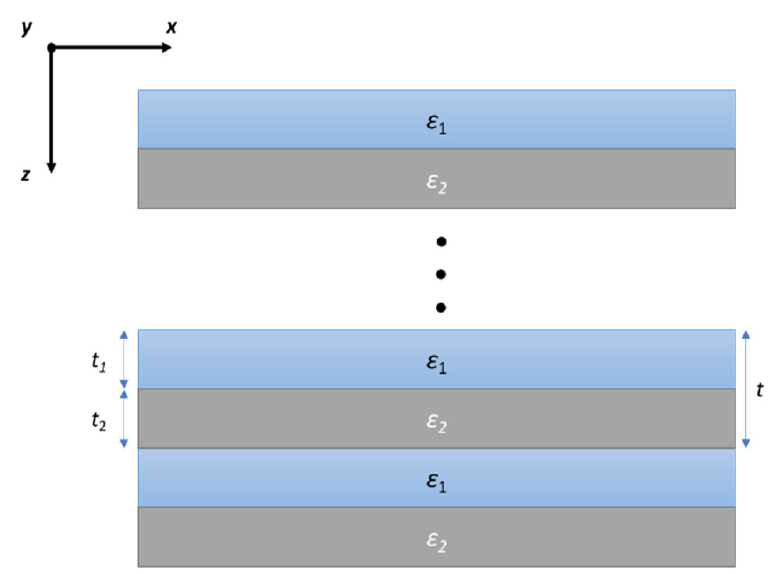
Figure 1. Schematic of a multilayer HMM structure.